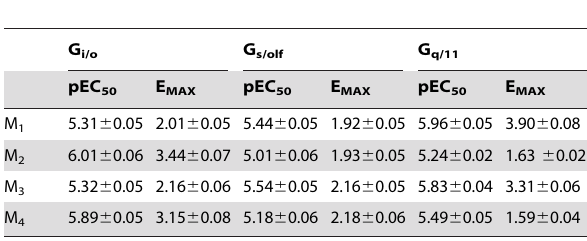
Table 1. Stimulation of [ 35 S]GTP c S binding by carbachol to G i/o , G s/olf and G q/11 subtypes of G-proteins via M 1 through M 4